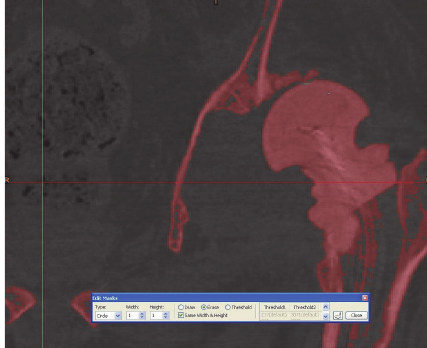
Figure 4: Segmenting the femur from the acetabulum using Materialise MIMICS 14.12.